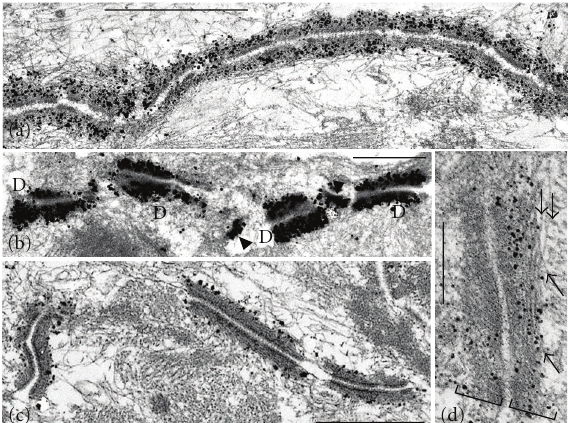
Figure 5: Immunoelectron microscopy of ultrathin sections through bovine myocardium (a) and Purkinje fibers ((b)–(d)) using antibodies against desmoplakin. (a) Immunogold labeling of a typical extended area composita structure in an intercalated disk (ID) of adult cardiomyocytes. (b) By contrast, note the relatively small desmoplakin-positive junctions that connect cells of the Purkinje fiber conductive system ((d), desmosomes; arrowheads denote some particularly small desmosome-like junction structures with asymmetric labeling). The desmoplakin-rich plaques of such junctions are very intensely labeled. (c) The morphology and the relatively close packing of the major type of junctions are similar to those of the area composita structures of adult mammalian cardiomyocytes. (d) High-magnification immunoelectron micrograph of a composite junction. Note the very close near parallel association of intermediate-sized filaments (some are denoted by arrows) with junctional plaques. Bars in (a) and (b): 1 μ m; bar in (c): 0.25 μ m.